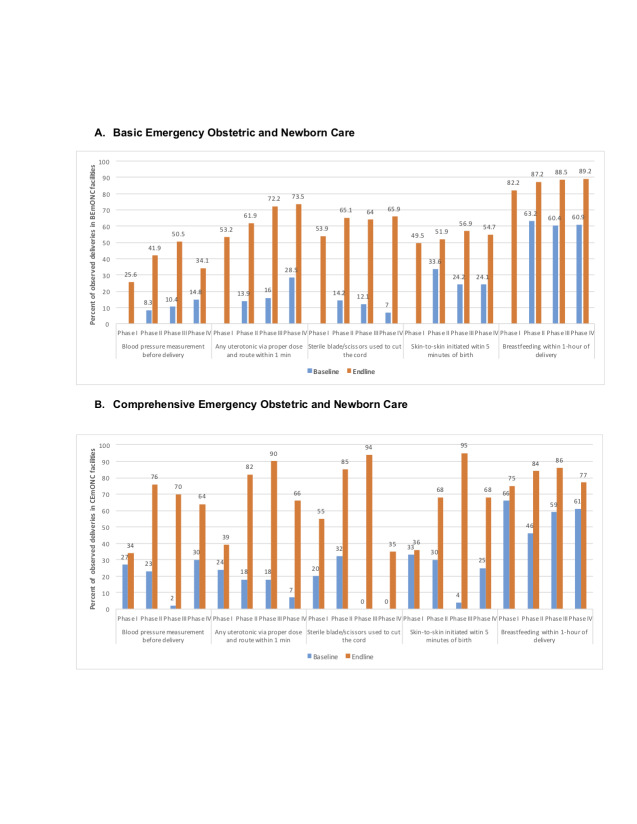
Changes in maternal and newborn practices before and after the AMANAT intervention: Bihar, 2014-2017. Panel A. Basic emergency obstetric and newborn care. Panel B. Comprehensive emergency obstetric and newborn care. Data are from Direct Observation of Deliveries conducted in conjunction with the four phases of the AMANAT intervention between 2014 and 2017. Phase I baseline data in Basic Emergency Obstetric and Newborn Care facilities were incomplete, thus not shown. All P-values comparing endline vs baseline levels are statistically significant at P < 0.05. AMANAT, Apatkalin Matritvaevam Navjat Tatparta (translated Emergency Maternal and Neonatal Care Preparedness).